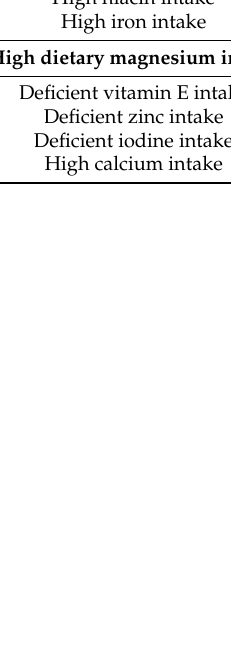
Table 7. Association between bone conduction speed (BCS) through bioelectrical impedance analysis (BIA) with anthropometric parameters ( n = 78) [42].